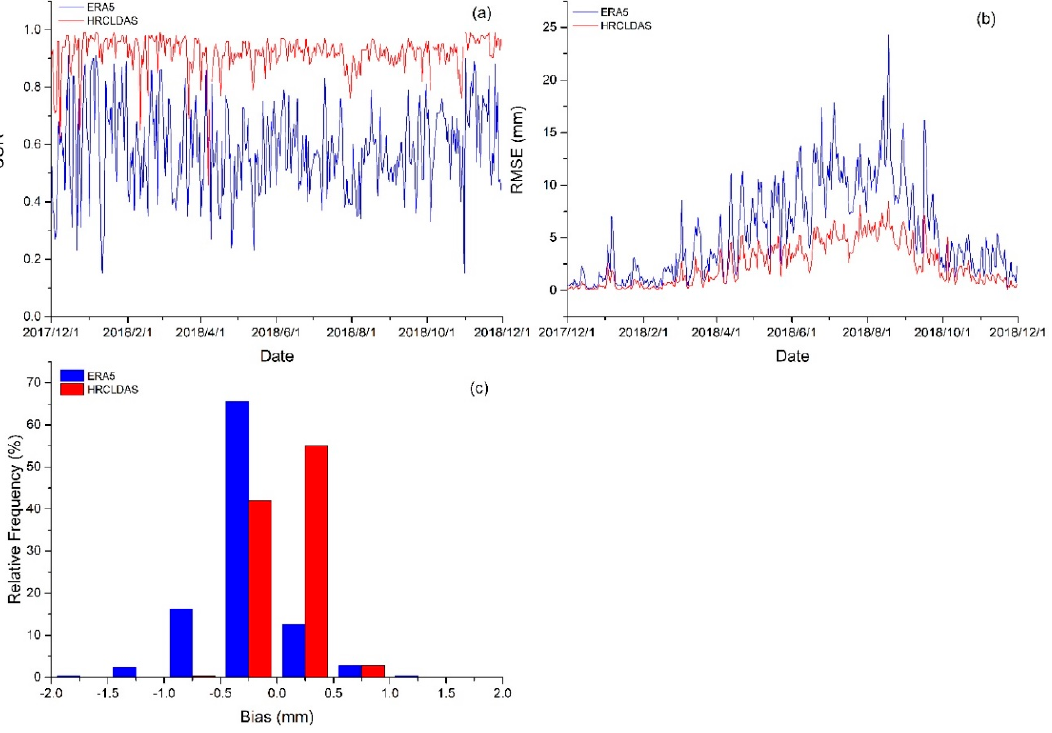
Figure 8. ( a ) Time series of COR; ( b ) time series of RMSE; ( c ) frequency distribution of bias.